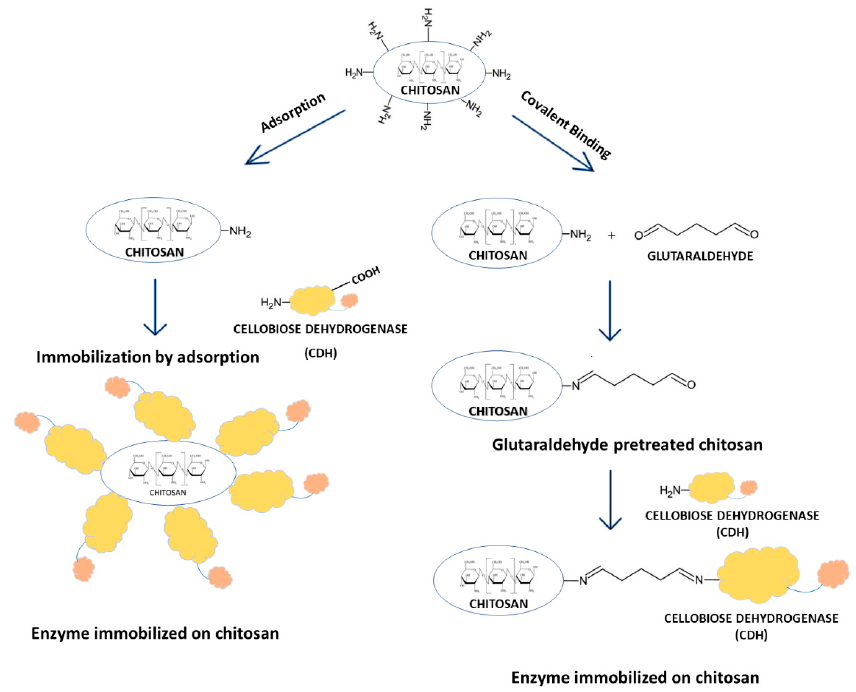
Figure 1. Immobilization of cellobiose dehydrogenase on chitosan through direct adsorption and covalent attachment using glutaraldehyde .